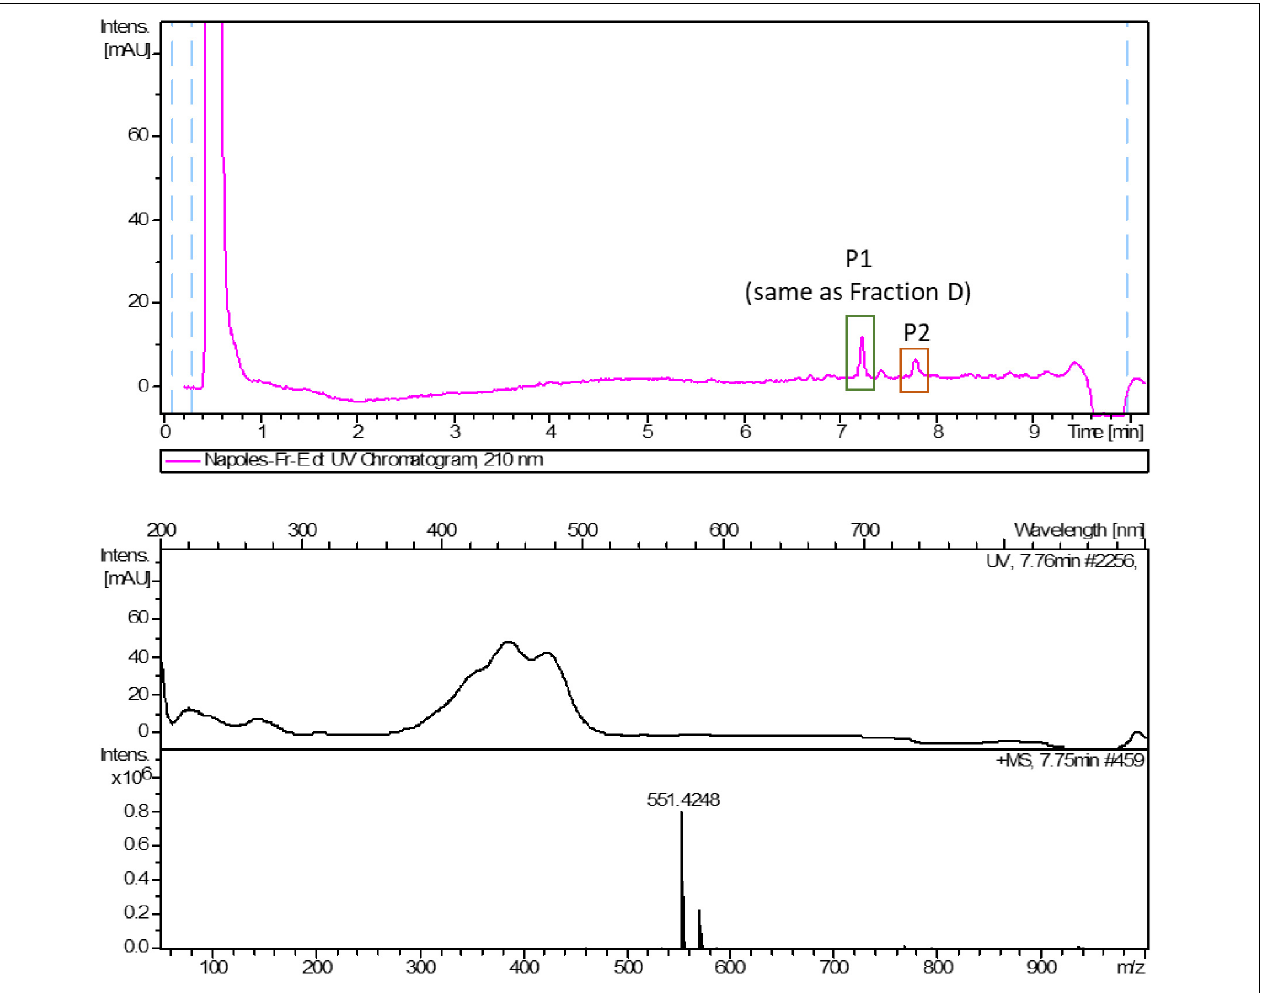
FIGURE 4 | LC-UV trace of fraction E from D. tertiolecta and UV and HRESIMS spectra of peak P2.